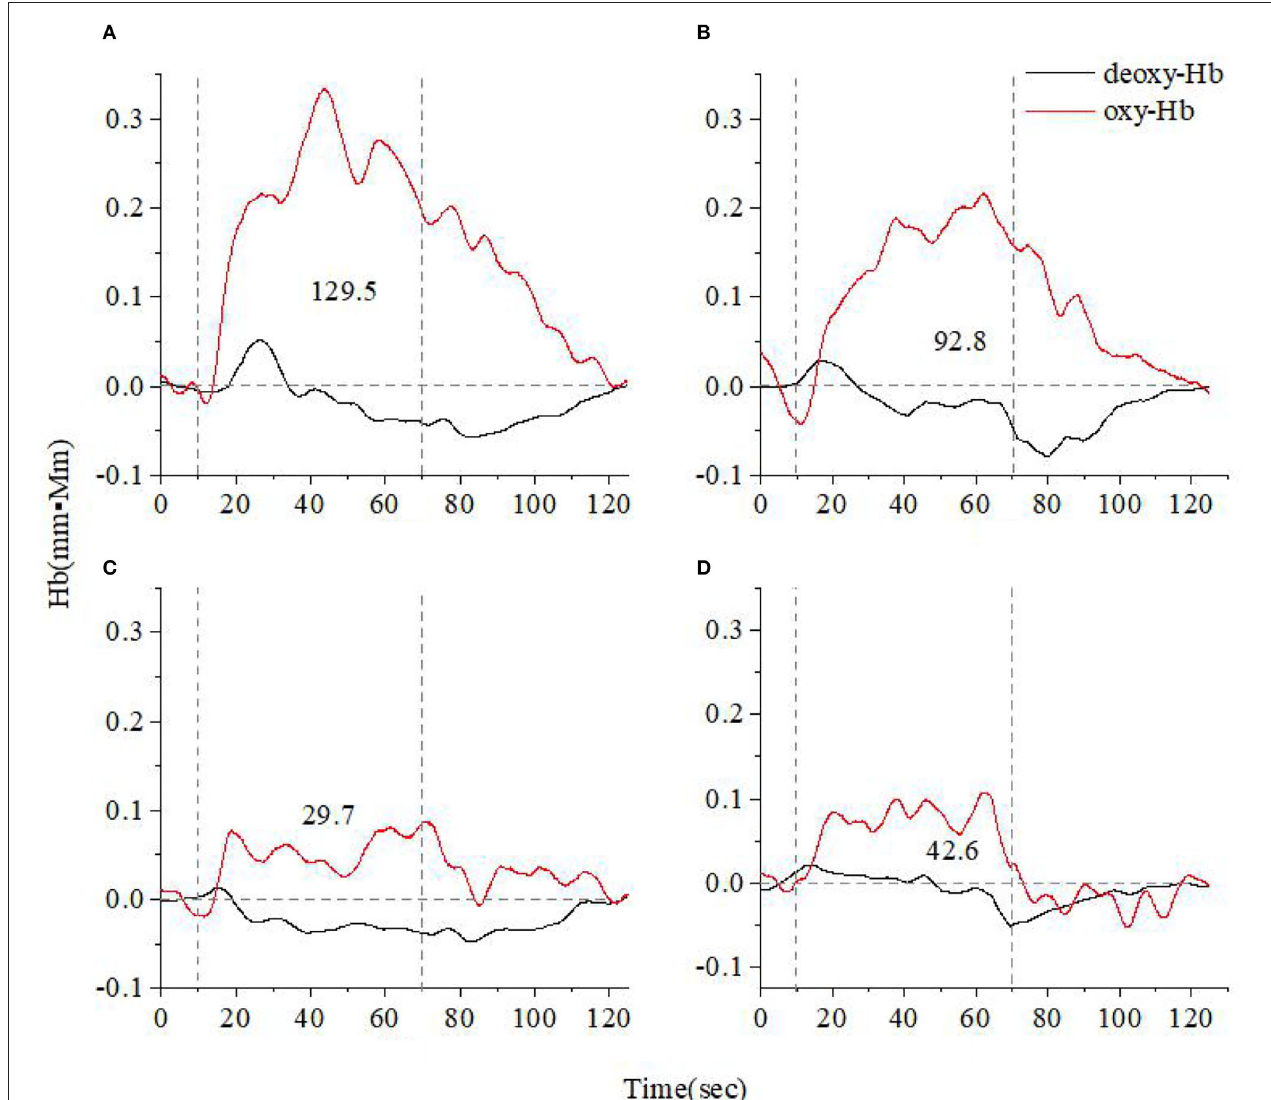
FIGURE 3 | Time course of the average hemoglobin concentration of 10 people under verbal fluency task (VFT) (A) . Time course of the average hemoglobin concentration of 10 anxiety and depression patients at the acute (B) , consolidation (C) , and maintenance stages (D) . All of them completed the VFT. The red line indicates the amount of change in oxyhemoglobin concentration (oxy-Hb), and the black line indicates the amount of change in deoxyhemoglobin concentration (deoxy-Hb). The numbers indicate integral